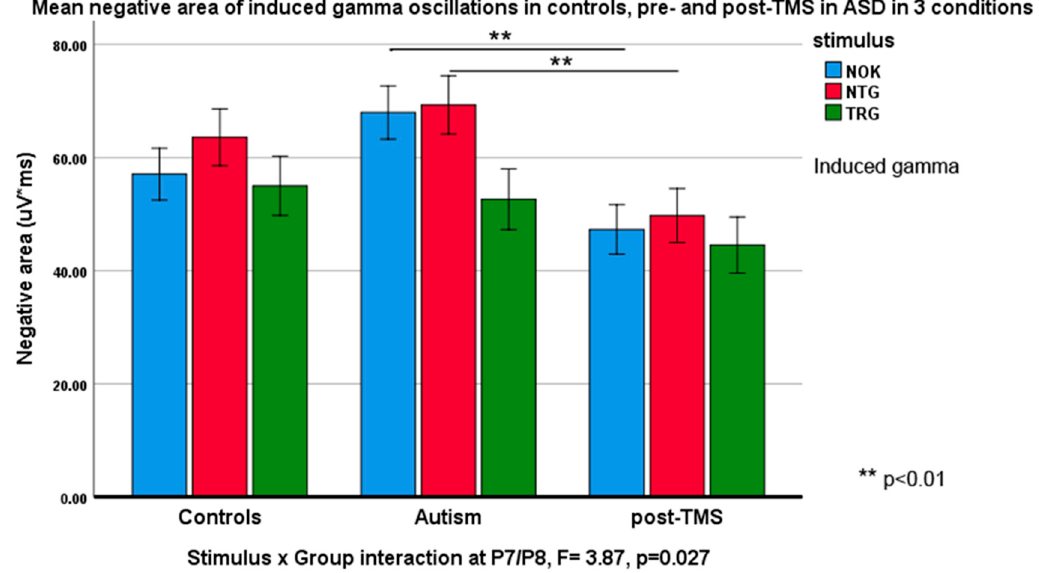
Figure 6. Negative slope area (Mean ± SE) of induced gamma oscillations in response to target Kanizsa (TRG), non-target Kanizsa (NTG) and non-Kanizsa (NOK) stimuli in typical children, children with ASD pre- and post-TMS treatment. Stimulus (TRG, NTG, NOK) × Group (CNT, ASD pre-, ASD post-TMS) interaction was significant at the inferior parietal sites (P7, P8). Note higher area of response at baseline and a decrease of areas in response to non-target items post-TMS similar to e ff ects at the frontal sites. Negative area of induced gamma to targets was higher in ASD as compared to CNT only at P7 site (F 1,36 = 4.97, p = 0.032). TMS decrease negative area of the induced gamma to NTG at P3, P4, P7, and P8 (all p < 0.05), and to NOK stimuli at P3 and P7 (both p <